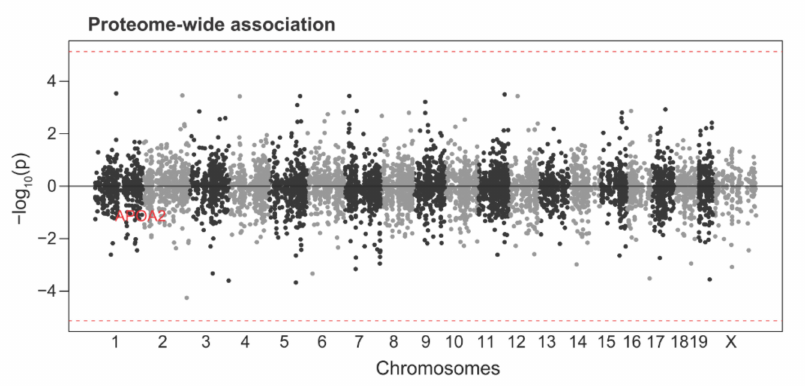
Figure 4. Proteome-wide association study (PWAS) revealed a non-significant association between the plasma HDL and APOA2. Manhattan plot depicting the associations of proteins with positive effects (increased expression leads to higher HDL levels) and proteins with negative effects (increased expression leads to lower HDLs). Proteins were plotted across the chromosomes with x-axis as the chromosome coordinates and y-axis as the significance of the association. The threshold for proteome-wide significance was determined based on the number of proteins tested ( p < 7.4 × 10 − 6 , red dashed line).